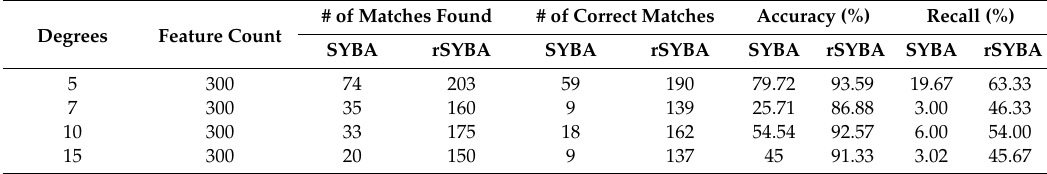
Table 2. Accuracy comparison for Rotation Image Sequence.